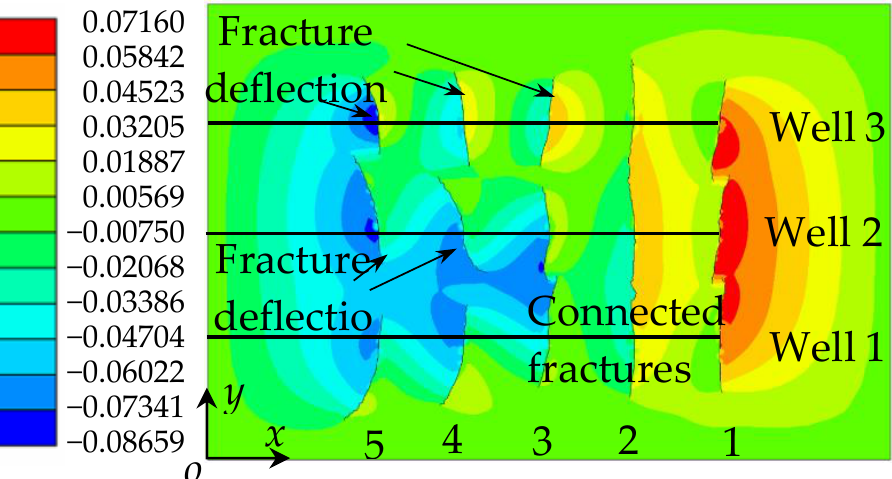
Figure 7. Final fracture network morphology and deformation in multi-well fracturing; b = 100 m.